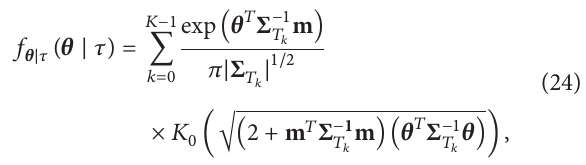
Table 5. The pdf of elevation 𝜃 , which can be DOD elevation